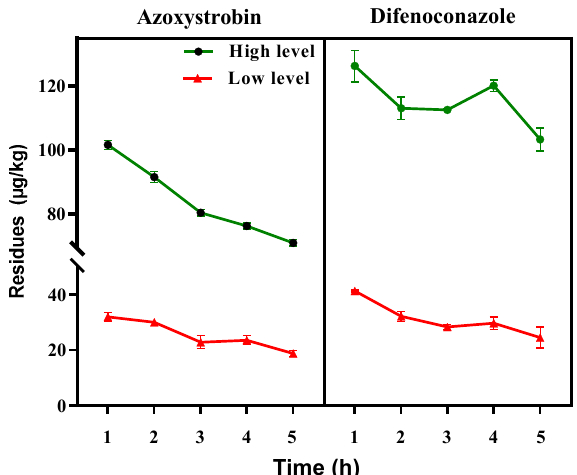
Figure 4. Changes in the concentrations of azoxystrobin and difenoconazole in PRA during soaking and moistening.